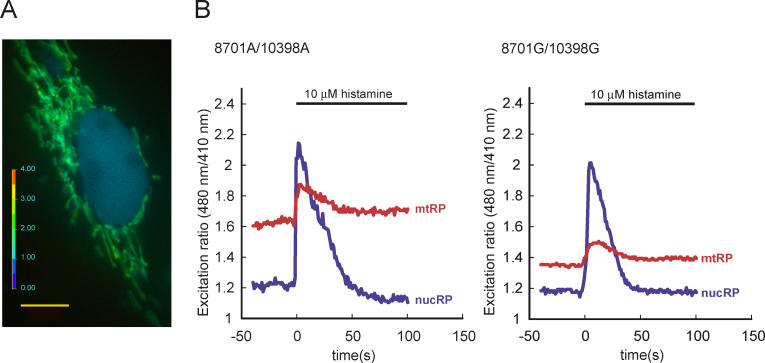
Typical Excitation Ratio Image of a Cybrid and Histograms Showing Responses to Histamine(A) Image of a typical cybrid showing fluorescence ratios of excitation at 480 nm to 410 nm in pseudocolors. Mitochondria had a higher 480 nm/410 nm ratio than the nucleus, possibly reflecting higher calcium levels and pH in mitochondrial matrix than in cytosol. Scale bar, 10 μm.(B) Representative fluorescence ratio responses of 8701A/10398A cybrids (left) and 8701G/10398G cybrids (right) evoked by 10 μM histamine. The y axis shows the ratio of the 525 nm fluorescence at 480 nm to that at 410 nm. Blue traces show the ratio in the nucleus and red traces show the ratio in mitochondria. Histamine (10 μM) was added at time 0 s and was not washed out during the experiment.